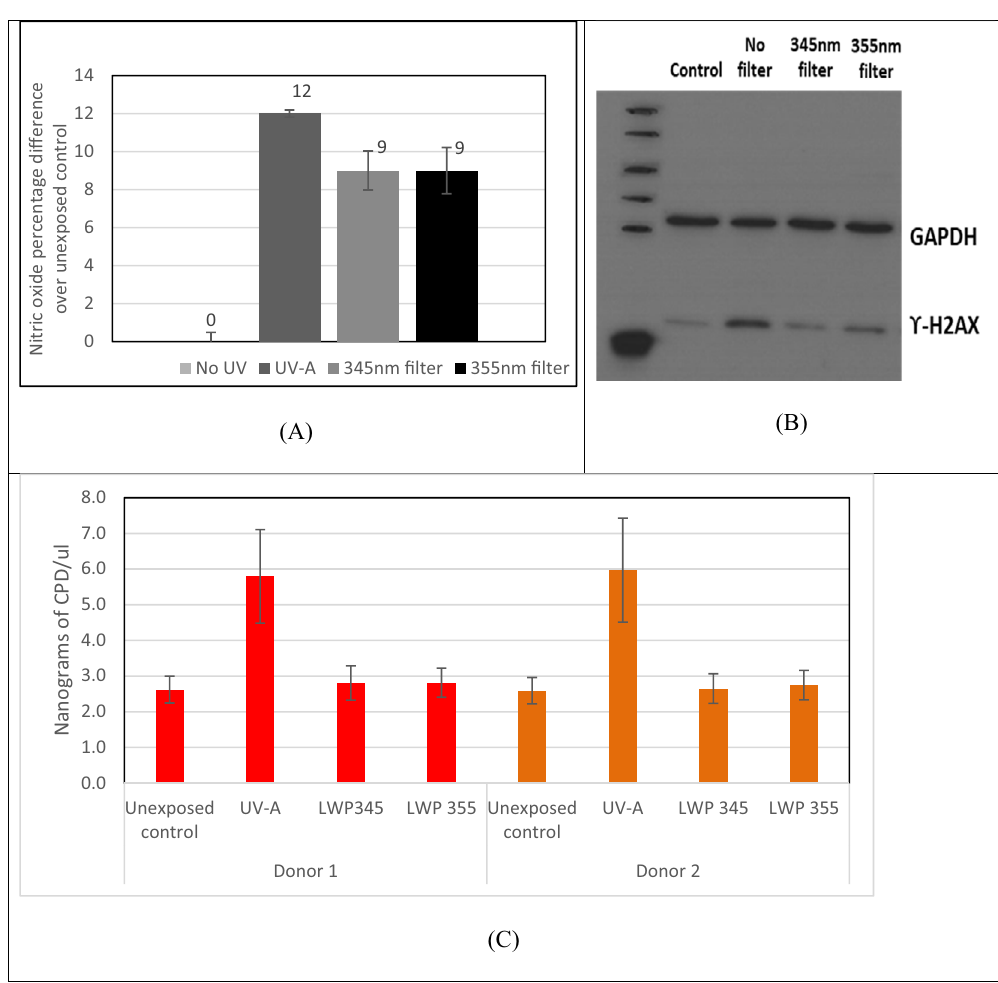
Figure 2. Primary neonatal foreskin keratinocytes exposed to 9 J/cm2 full spectrum UV-A, or UV-A filtered through 345 nm or 355 nm long-pass filters. All samples were compared against unexposed samples kept in the dark at the same temperature and hence subjected to minimal/low levels of background exposure as possible. ( A ) Nitric oxide produced following exposure; ( B ) DNA damage via western blotting of gamma H2AX; ( C ) CPD levels elicited by exposure: donor 1 (red bars), donor 2 (orange